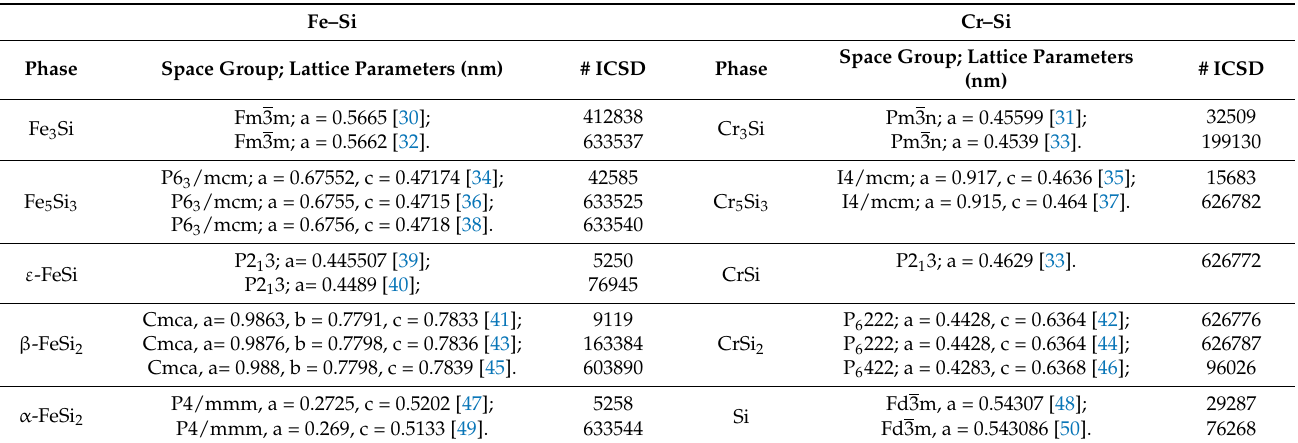
Table 1. Chemical and phase composition of binary Fe and Cr